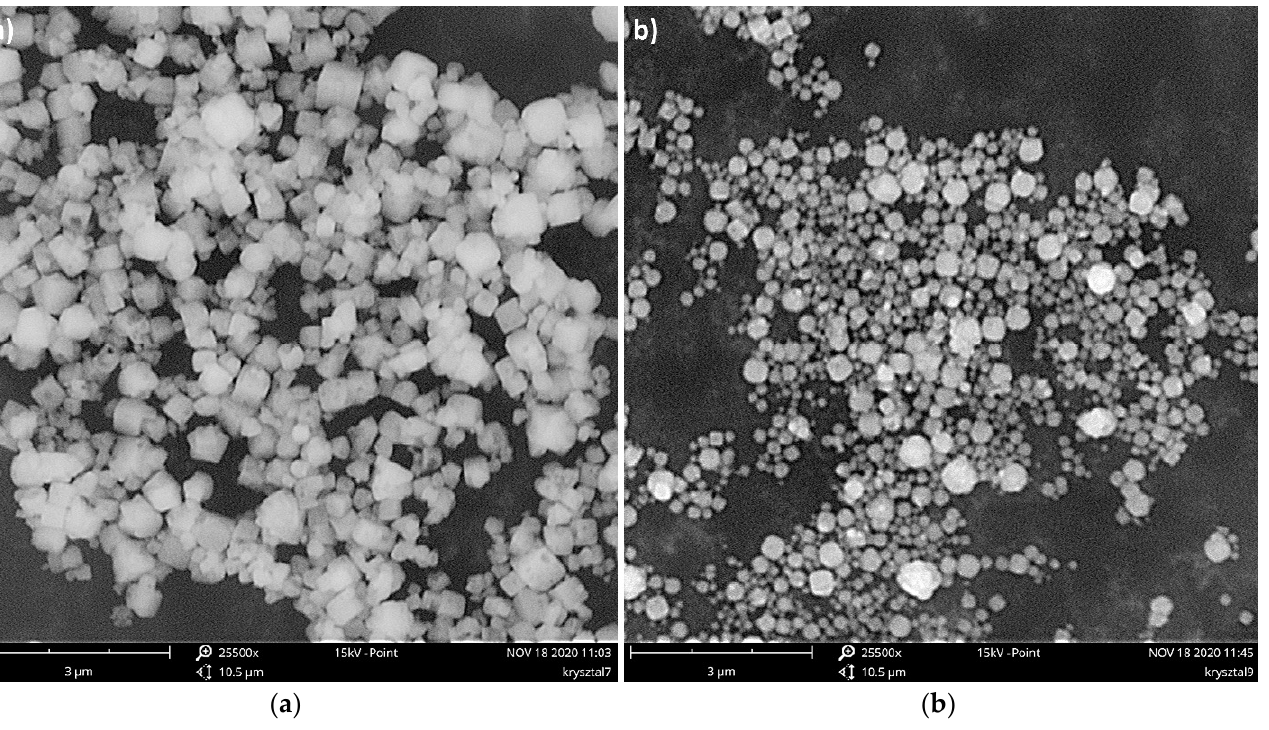
Figure 9. The shape of CaF 2 particles precipitated in the US-assisted STR—SEM images ( ε US = 14.9 W/kg). Magnification 25,500×, size bare: 3 μ m; ( a ) ε mix = 1 W/kg; ( b ) ε mix = 3